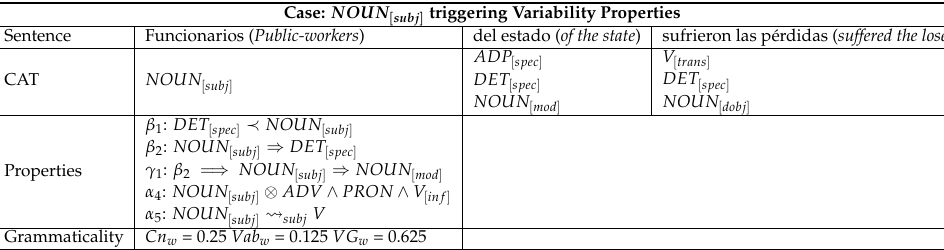
Table 8. Variability properties of NOUN [ subj ]